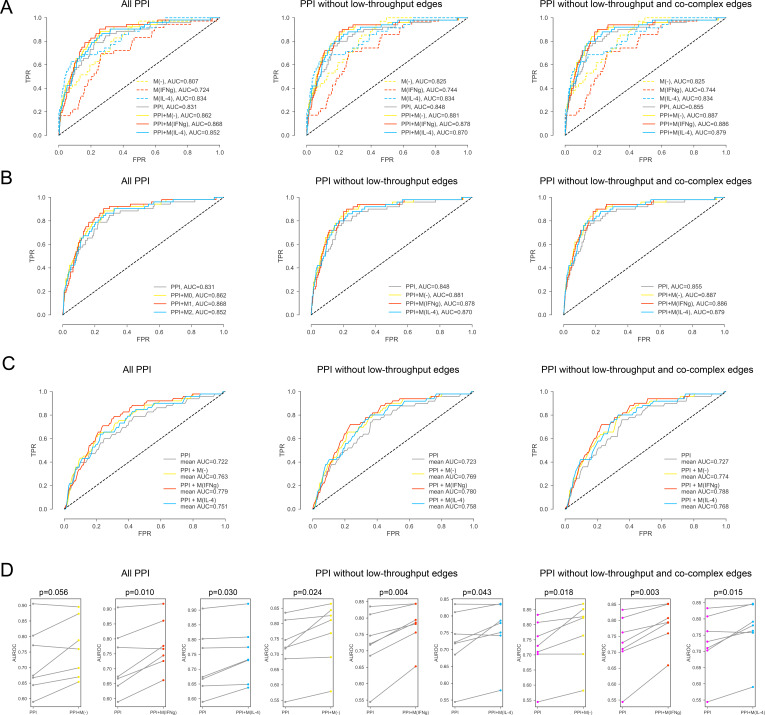
For the iCTNet CVD drug targets.(A) ROC curves for M(-), M(IFNγ), M(IL-4), PPI, PPI + M(-), PPI + M(IFNγ) and PPI + M(IL-4), comparing the original PPI, PPI with low-throughput edges removed, and PPI with low-throughput and co-complex edges removed. (B) ROC curves for PPI, PPI + M(-), PPI + M(IFNγ) and PPI + M(IL-4), comparing the original PPI, PPI with low-throughput edges removed, and PPI with low-throughput and co-complex edges removed. (C) The k-fold cross-validated (k = 7) ROC curves for, PPI + M(-), PPI + M(IFNγ) and PPI + M(IL-4), comparing the original PPI, PPI with low-throughput edges removed, and PPI with low-throughput and co-complex edges removed. (D) The AUROC values of each individual fold from the cross-validation for PPI and PPI + M(-), PPI and PPI + M(IFNγ), PPI and PPI + M(IL-4), comparing the original PPI, PPI with low-throughput edges removed, and PPI with low-throughput and co-complex edges removed. Paired t-test was performed to obtain two-sided p-values.